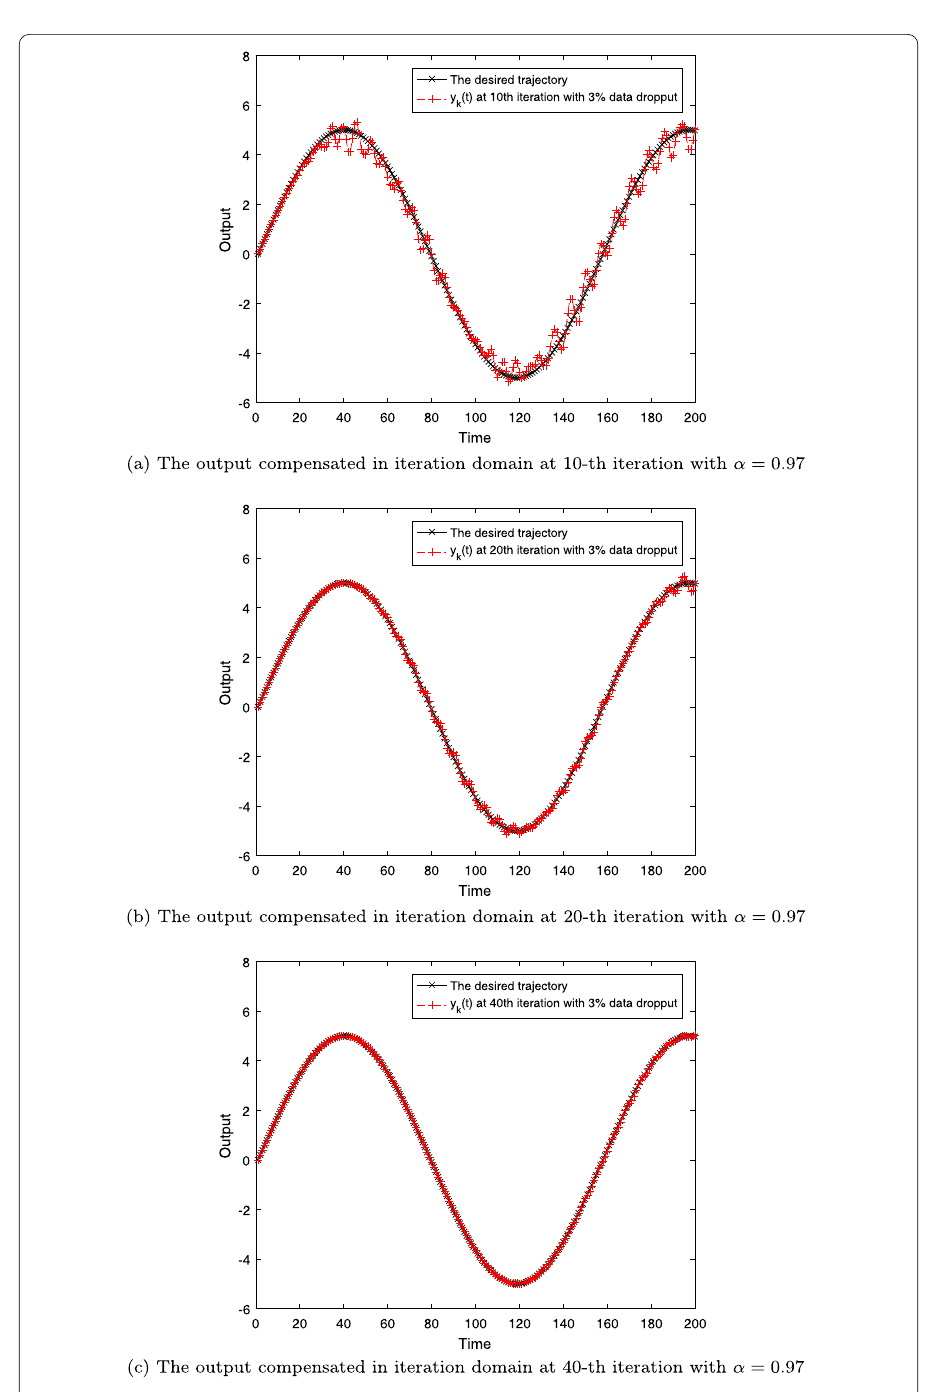
Figure 7 The output compensated in iteration domain at different iterations with α =